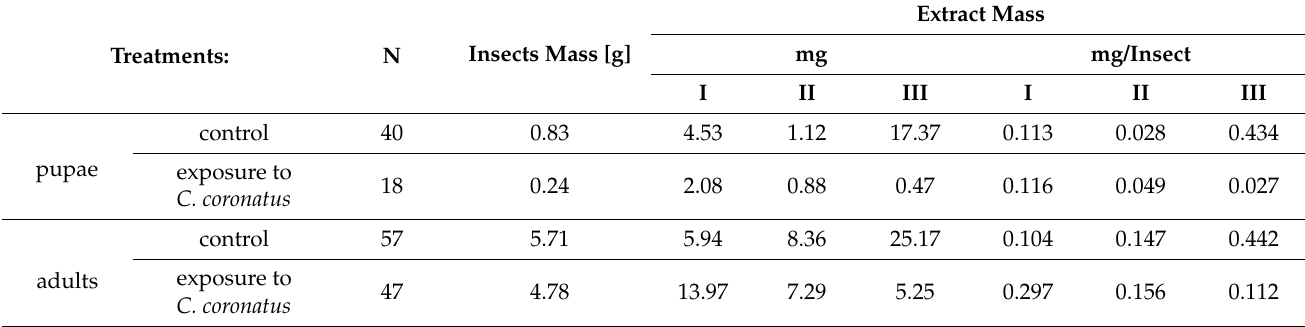
Table 1. The numbers of Sarcophaga argyrostoma pupae and adults used for extraction and masses of extracts obtained.